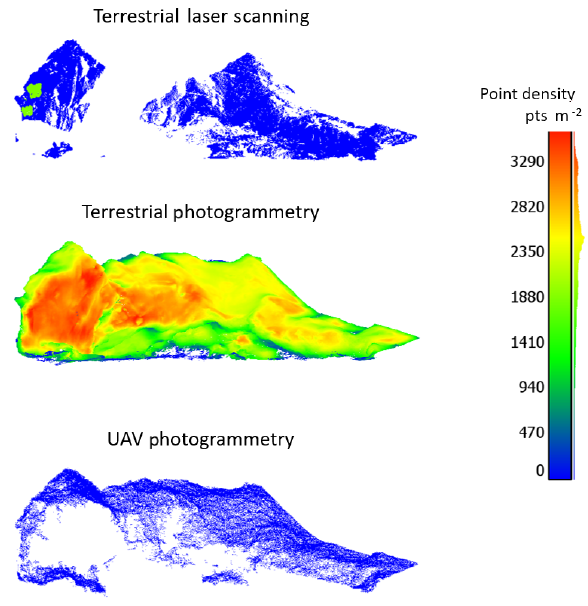
Figure 5. Maps of point density in sample location